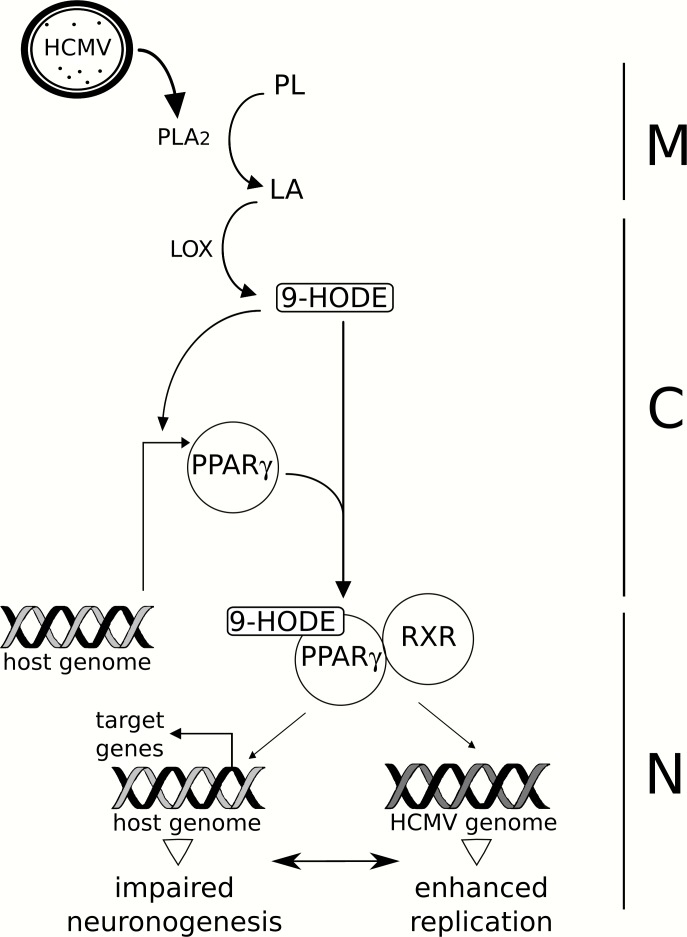
Proposed model for the role of PPARγ during HCMV infection of NSCs.HCMV particles (HCMV) carry onboarded a cell-derived packaged cPLA2 (oPLA2, dots), which catalyzes the release of linoleic acid (LA) from host membrane phospholipids (PL) upon infection. LA undergoes oxidization driven by 15-lipoxygenase (LOX), which generates 9-HODE. 9-HODE, in turn, increases PPARγ levels. Activated PPARγ dimerizes with RXR to regulate the expression of host and viral genomes, resulting in impaired neuronogenesis in vitro and enhanced viral replication. M: cell membrane, C: cytoplasm, N: nucleus.